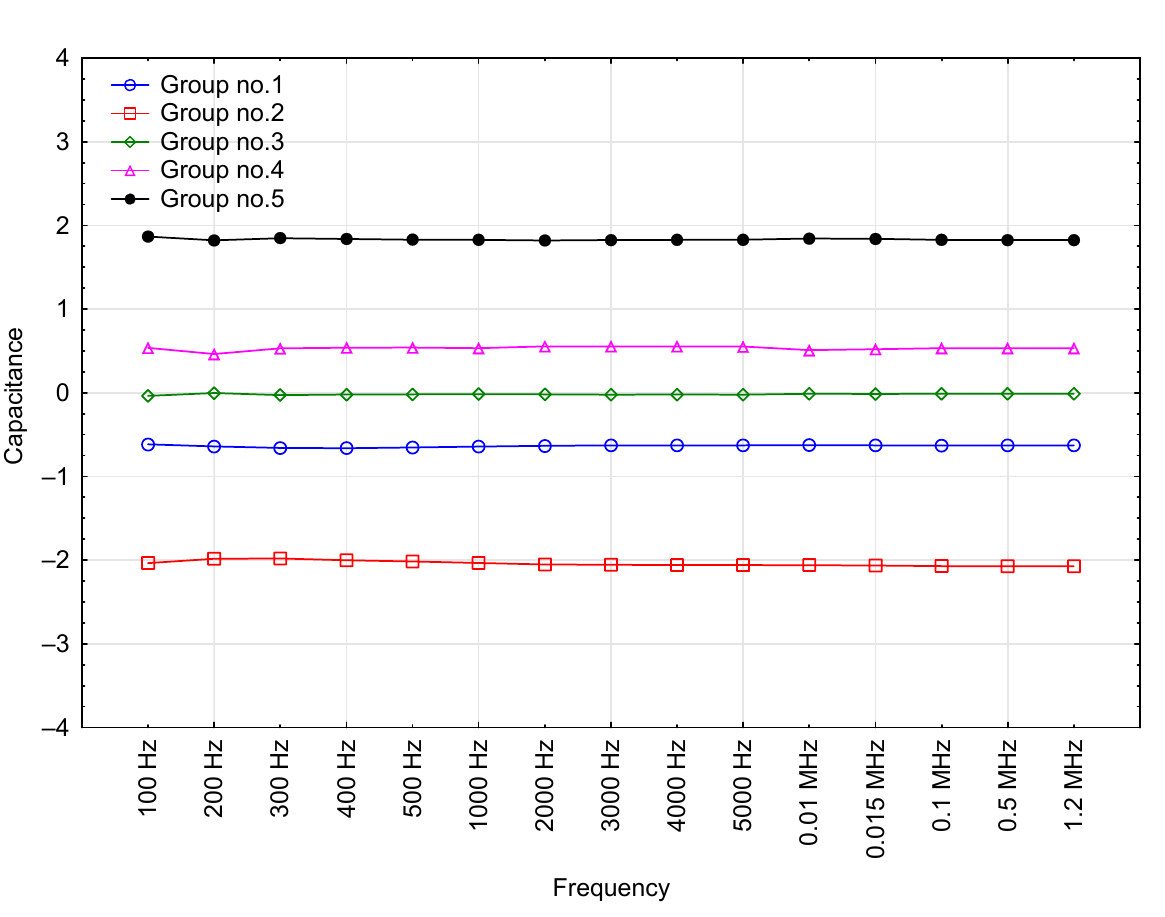
Figure 13. The effect of test voltage frequency on the average capacitance value of engine oils in each cluster (grouped by k-means). Table 8. The assignment of the oils into the different groupings according to similarity in capaci- tance values.